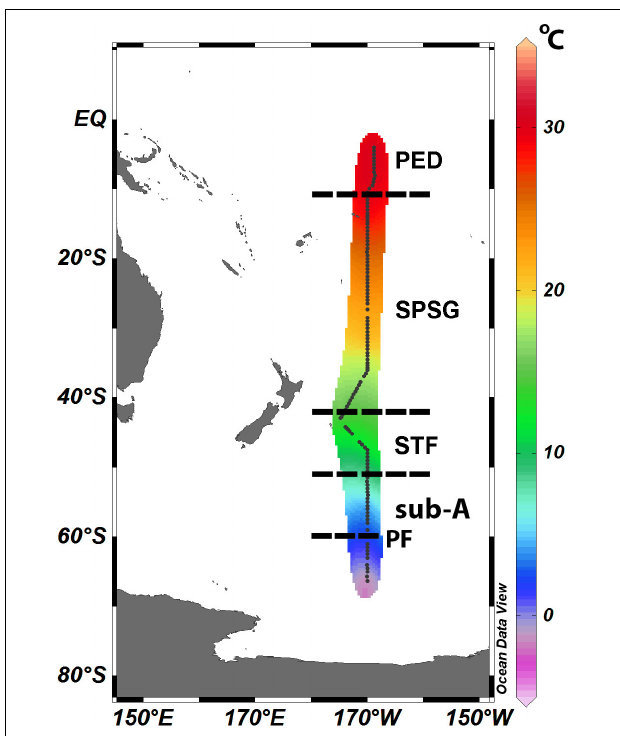
FIGURE 1 | Water masses along the P15S GO-SHIP transect. Dashed lines delineate the four oceanographic provinces according to Longhurst (2010): (1) the Sub-Antarctic (Sub-A) between 66 ◦ S and 52 ◦ S, including the Polar Front (PF; at 60 ◦ S), (2) the Subtropical front (STF) between 52 ◦ S and 40 ◦ S, (3) the South Pacific Subtropical Gyre Province (SPSG) between 40 ◦ S and 10 ◦ S, and (4) the Pacific Equatorial Divergence Province (PED), respectively, between 10 ◦ S and 0 ◦ S. Black dots represent CTD station locations. Sea surface temperature ( ◦ C) overlaid in color.